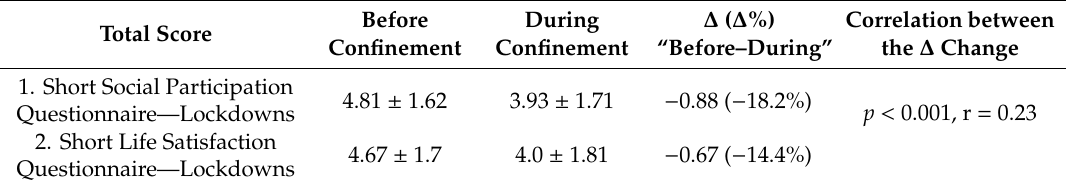
Table 6. Relationship between delta total score in SSPQL and